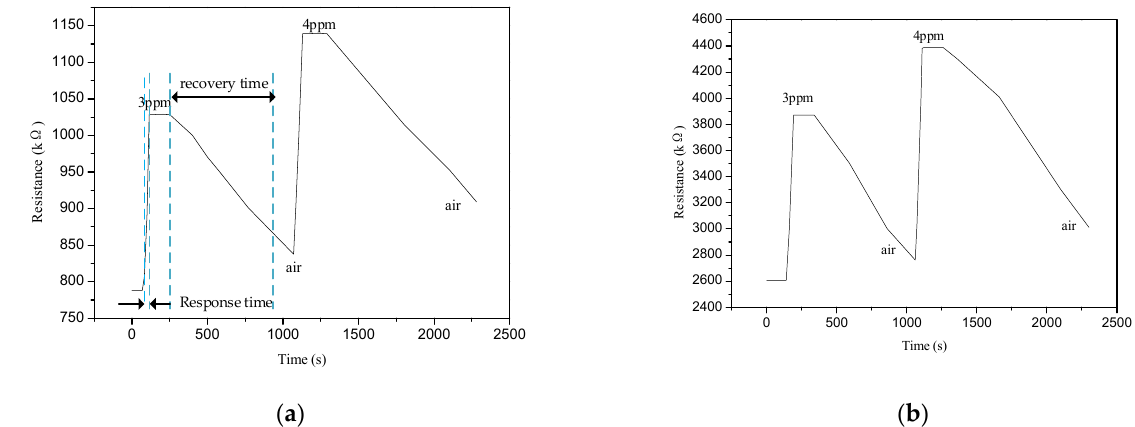
Figure 9. Gas sensor ammonia response and recovery curves. ( a ) PANI; ( b ) PANI/SnO 2 .